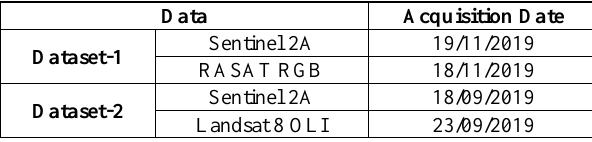
Table 1. Acquisition date of Sentinel 2A, RASAT and Landsat- 8 for study areas